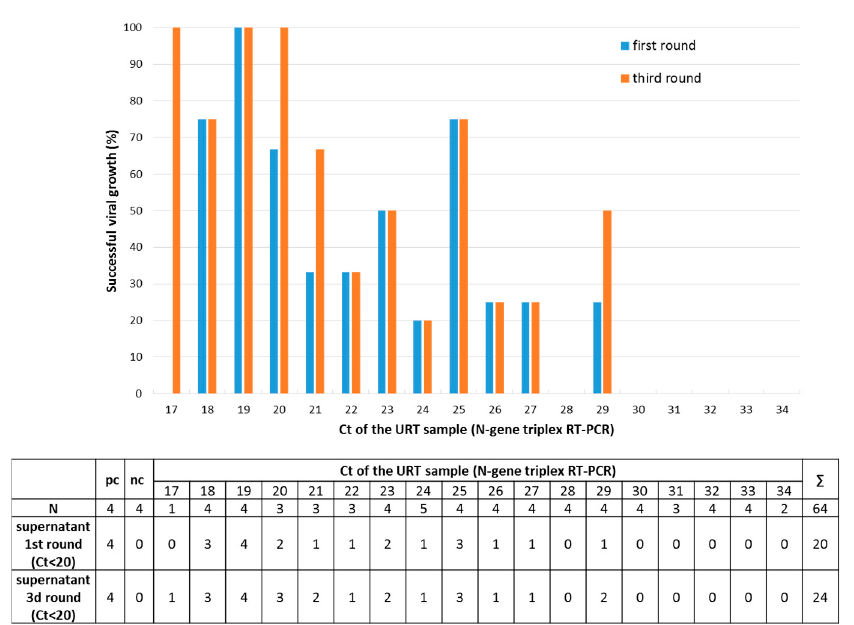
Figure 4. Isolation of SARS-CoV-2 from upper respiratory tract (URT) samples in Vero cells. A successful isolation in cell culture was assumed if the supernatant of the corresponding well had a threshold cycle (Ct) < 20 in the N-gene triplex RT-PCR. The isolation rate was estimated as a function of viral load by mean of the Ct (N-gene triplex RT-PCR) of the original URT sample. The results after the first round on Vero cells and after the third round are shown. Four positive and negative controls (pc, nc) were included. The table below the figure lists the result per URT sample and the corresponding Ct. The cytopathic effect observed after the third round in Vero cells is documented in Figure 5.